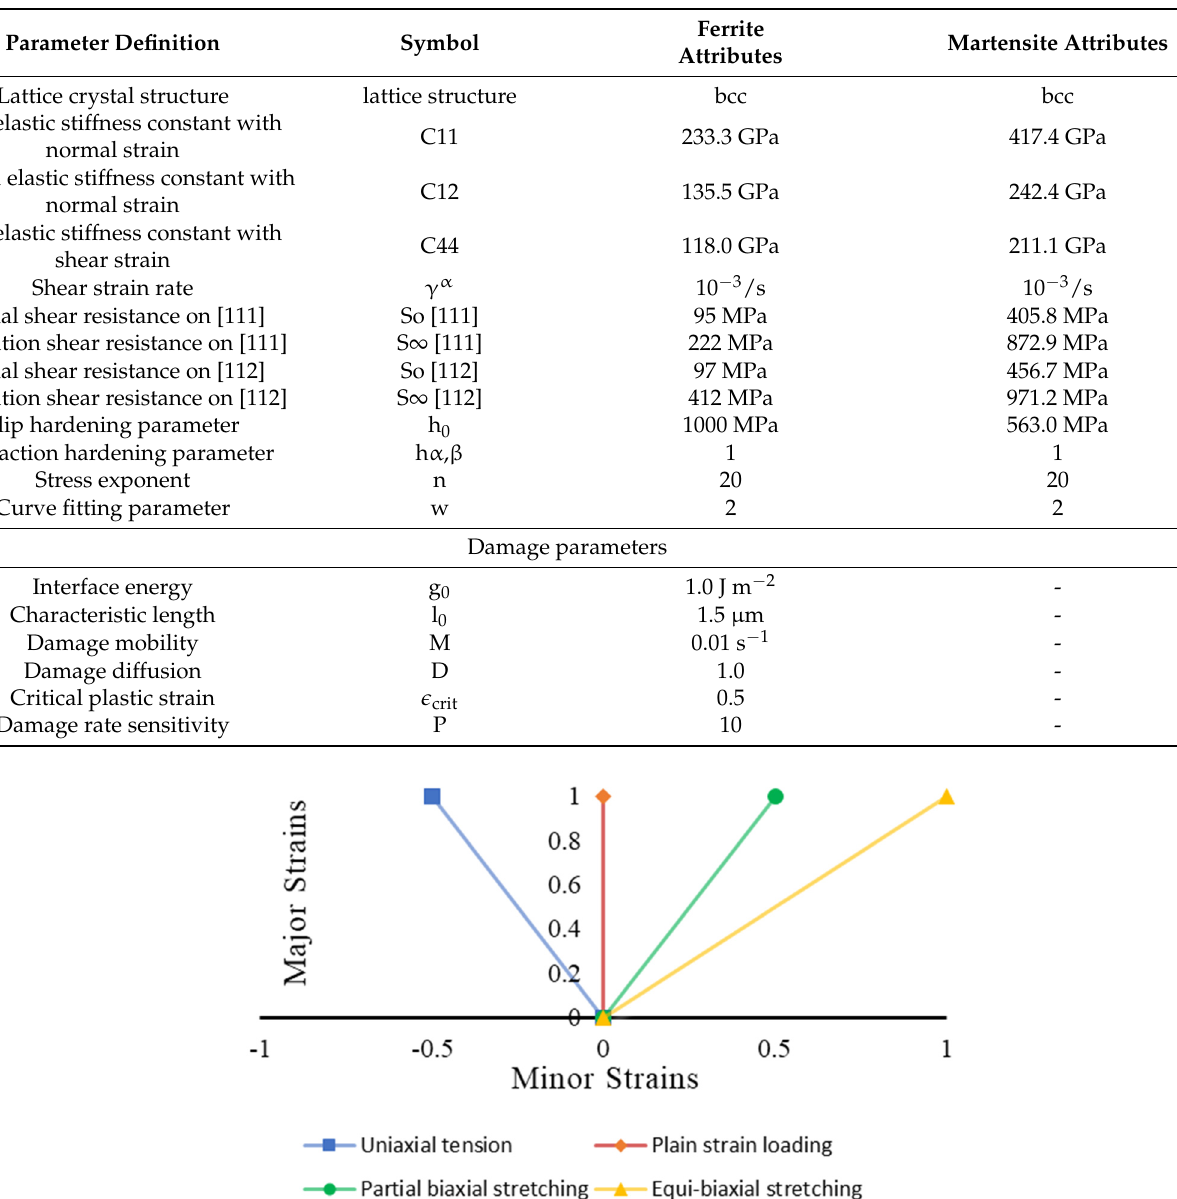
Table 3. Physical and fitting parameter values were adopted from the published literature for ferrite [29], reprinted with permission from Ref. [10] Copyright 2014 Elsevier, and martensite [7].